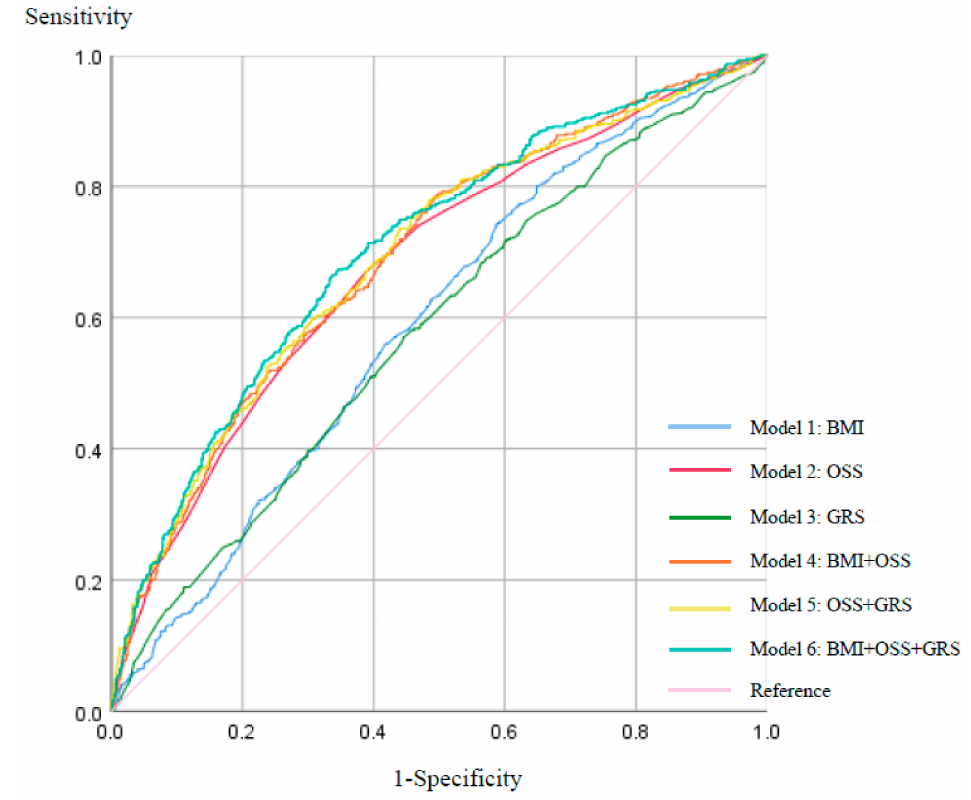
Figure 1. ROC curves for BMI, OSS, and